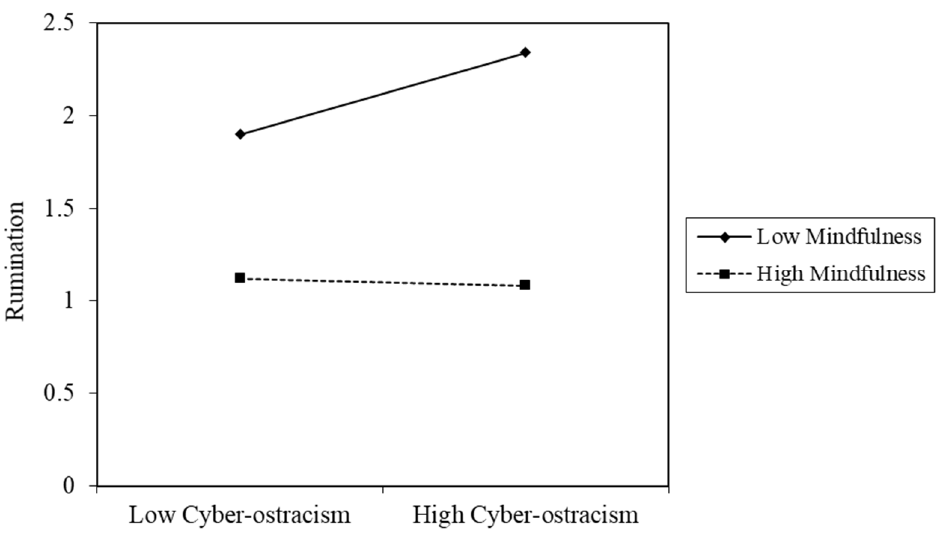
Figure 2. Mindfulness moderated the association between cyber-ostracism and rumination.